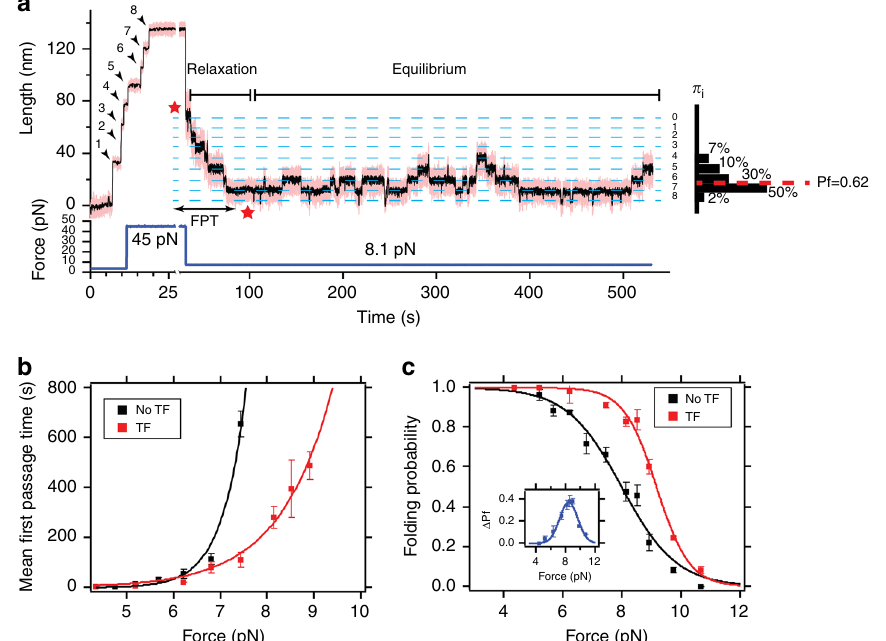
Fig. 2 Effect of trigger factor on the folding properties of protein L under force. a Representative force-clamp magnetic tweezers trajectory of a protein L octamer in presence of 500 μ M TF with the monitored properties highlighted. After the unfolding pulse, the molecule is set at a constant force (8.1 pN in this case), relaxing to an equilibrium state. The kinetic properties are re fl ected in the fi rst passage time (FPT), time taken to, starting with all domains unfolded, fold the eight domains for the fi rst time (time between arrows , highlighted ). In equilibrium, the molecule experiences several folding-unfolding transitions, re fl ected in different residence times at each folding state (labeled as the number of folded domains), marked with the dashed blue lines . The folding probability is calculated by monitoring the fraction of time spent on each of the states ( black bars ). b Mean-FPT for total refolding in presence ( red ) and absence ( black ) of TF. TF modulates the folding kinetics by speeding up the time needed to refold all eight domains. Above 7.4 pN, a protein L octamer needs over 1000 s to fold completely, while TF accelerates folding over an order of magnitude. Each data point represents the average of more than ten experiments. Error bars represent s.e.m. c Folding probability in presence ( red ) and absence ( black ) of TF. The presence of the molecular chaperone TF increases considerably the folding probability over the range from 7 to 10 pN. The inset shows the relative increment, reaching up to 40%. Data points are calculated as described above, using > 3000 s, and over more than three molecules per force. Error s bars are